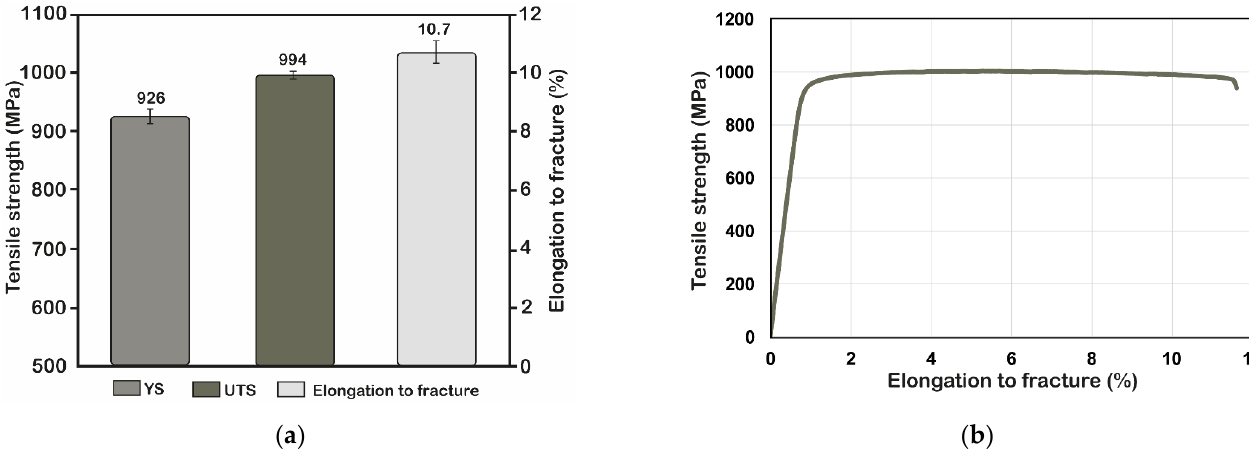
Figure 12. ( a ) Average YS, UTS and elongation to fracture of the DPF and heat-treated Ti-6Al-4V DPF femoral stem; ( b ) Representative stress–strain curve.